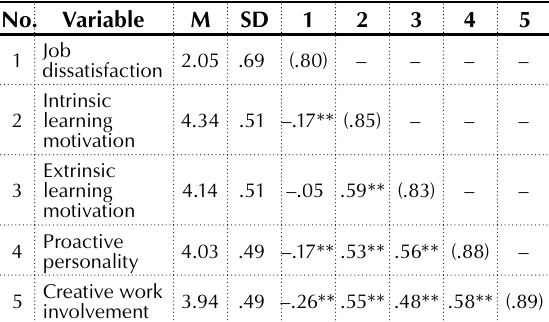
Table 2. Means, standard deviations, and